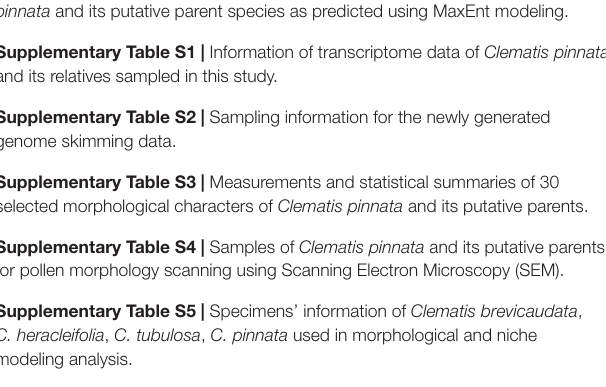
Supplementary Figure S1 | Natural distribution (blue dash circles) and collecting sites (points) of Clematis pinnata . Supplementary Figure S2 | Peak value image based on flow cytometry analysis of Clematis pinnata , C. tubulosa, and C. heracleifolia using C. brevicaudata as the external reference. Supplementary Figure S3 | The backbone of Clematis phylogeny inferred from the concatenated and coalescent based method using 3170 co-orthologous genes with exclusion the two putative taxa, C. pinnata and C. ochotensis . ML bootstrap values (MLBS) of the concatenated analysis were marked on the branches with ∗ indicating MLBS = 100. Supplementary Figure S4 | Optimal species networks of the eight populations of Clematis pinnata and its putative parents, as well as of closely related species, inferred using PhyloNet. The results display maximum pseudolikelihood trees with maximum zero to four reticulations allowed. Bar charts show probabilities of different maximum numbers of reticulations. Population location name abbreviations are explained in Table 2 . Supplementary Figure S5 | Optimal species networks of the BHS populations of Clematis pinnata and its putative parents, as well as of closely related species, inferred using PhyloNet with exclusion of another putative hybrid species C. ochotensis . The results display maximum pseudolikelihood trees with maximum zero to four reticulations allowed. Bar charts show probabilities of different maximum numbers of reticulations. Population location name abbreviations are explained in Table 2 . Supplementary Figure S6 | Chloroplast genome maps for Clematis pinnata . Thick lines on the complete outer circle identify the inverted repeat regions (IRa and IRb). The innermost track of the plastome shows the G + C content. Genes on the outside of the map are transcribed in a clockwise direction and genes on the inside of the map are transcribed in a counter-clockwise direction. INV, inversion; TP, transposition; IR, inverted repeats; LSC, large single copy; SSC, small single copy; Pi, nucleotide variability. Supplementary Figure S7 | Potential suitable distribution areas for Clematis pinnata and its putative parent species as predicted using MaxEnt modeling. Supplementary Table S1 | Information of transcriptome data of Clematis pinnata and its relatives sampled in this study. Supplementary Table S2 | Sampling information for the newly generated genome skimming data. Supplementary Table S3 | Measurements and statistical summaries of 30 selected morphological characters of Clematis pinnata and its putative parents. Supplementary Table S4 | Samples of Clematis pinnata and its putative parents for pollen morphology scanning using Scanning Electron Microscopy (SEM). Supplementary Table S5 | Specimens’ information of Clematis brevicaudata , C. heracleifolia , C. tubulosa , C. pinnata used in morphological and niche modeling